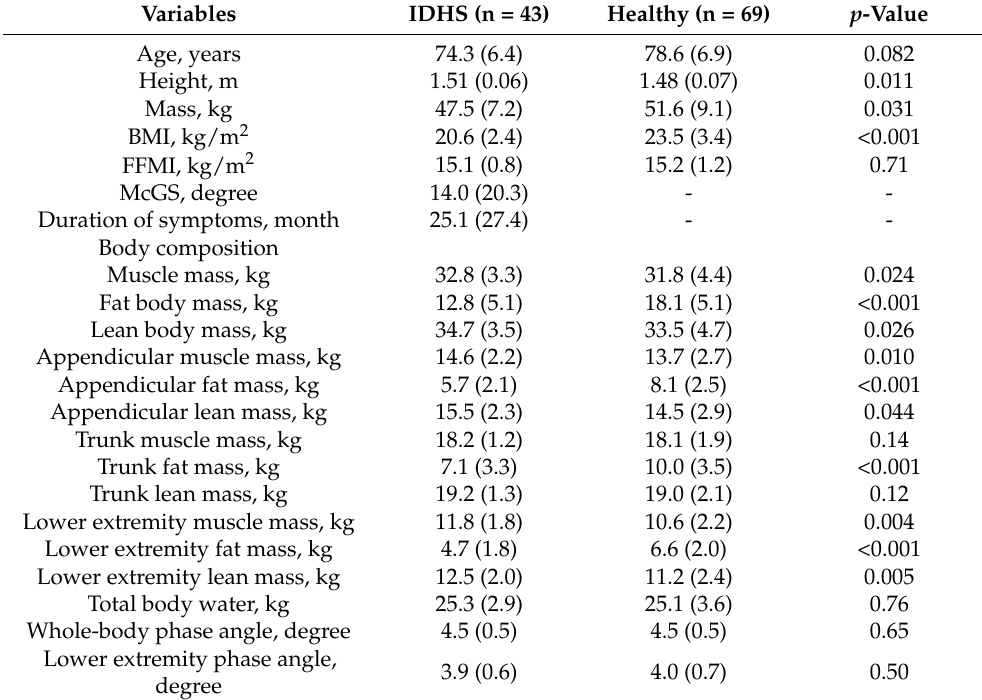
Table 1. Demographic data and results of comparison between IDHS and healthy groups.